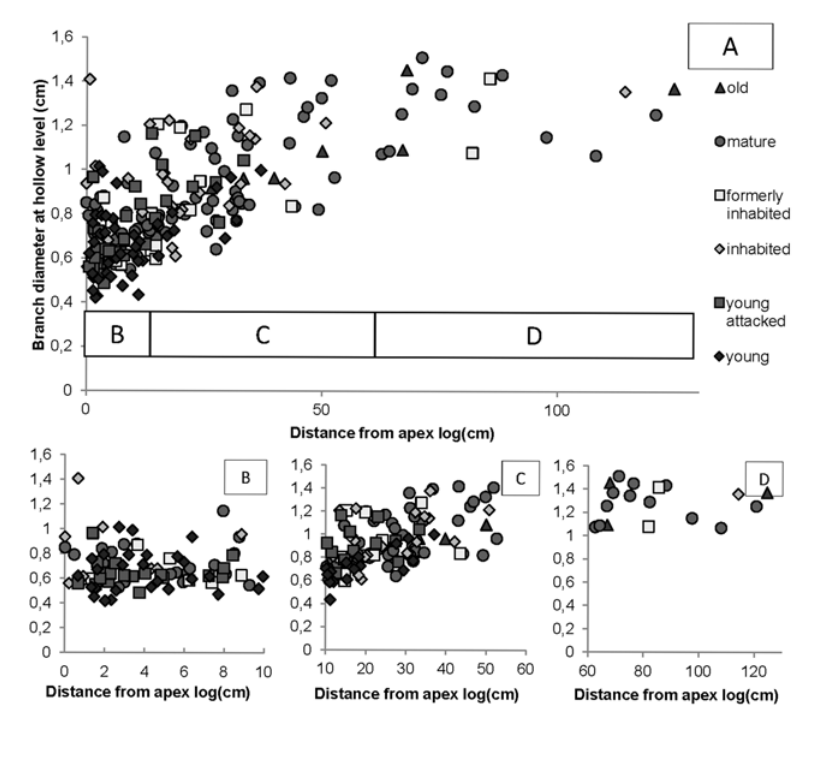
Fig. 3. A. Distance of the different types of cavities from the apex and branch diameter. B, C & D: Detailed views of portions of graph A. Note that young cavities are only observed up to 40 cm from the apex and inhabited cavities are mainly observed up to 50 cm from the